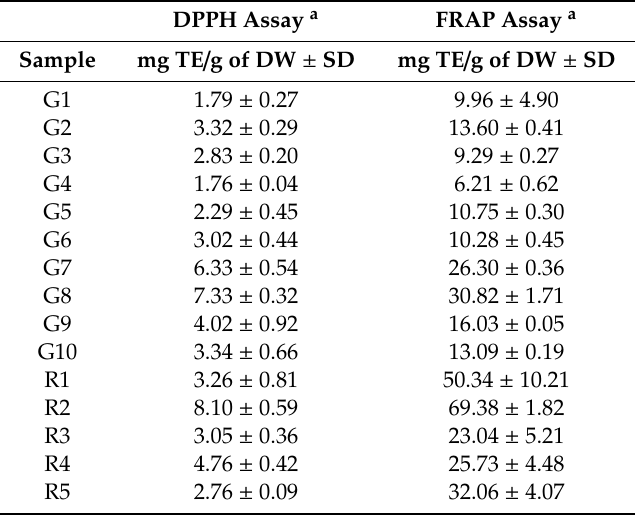
Table 3. Trolox equivalent (TE) of the granule and herb / decoction piece samples of dried weight (DW) using DPPH and FRAP assays, respectively.